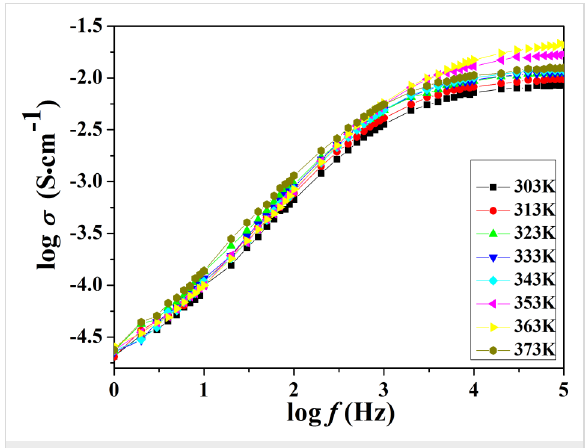
Figure 8: Variation of the ionic conductivity as a function of frequency at various temperatures.